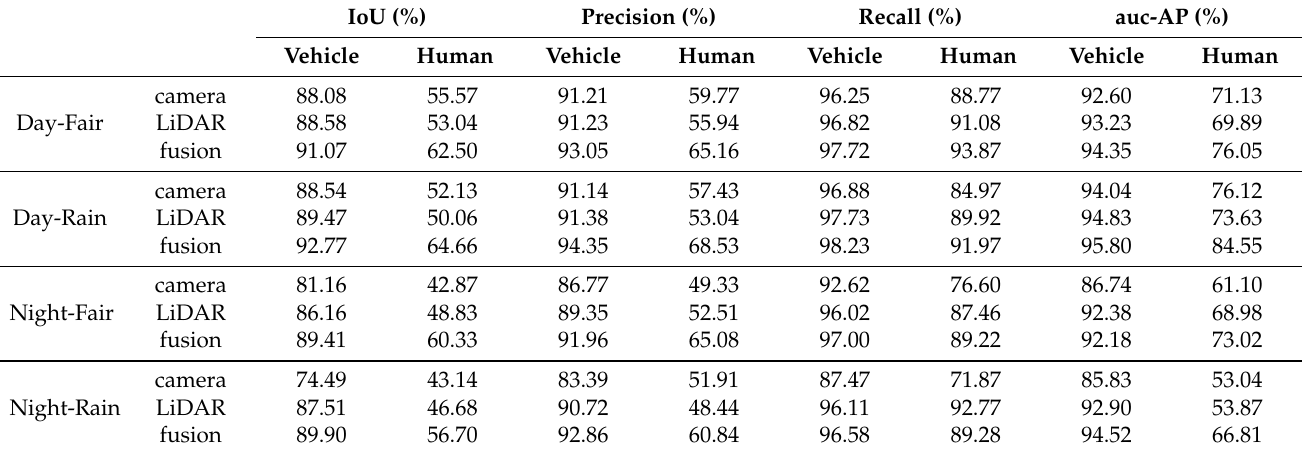
Table 2. Performance of supervised learning Waymo baseline models tested by the Waymo dataset.